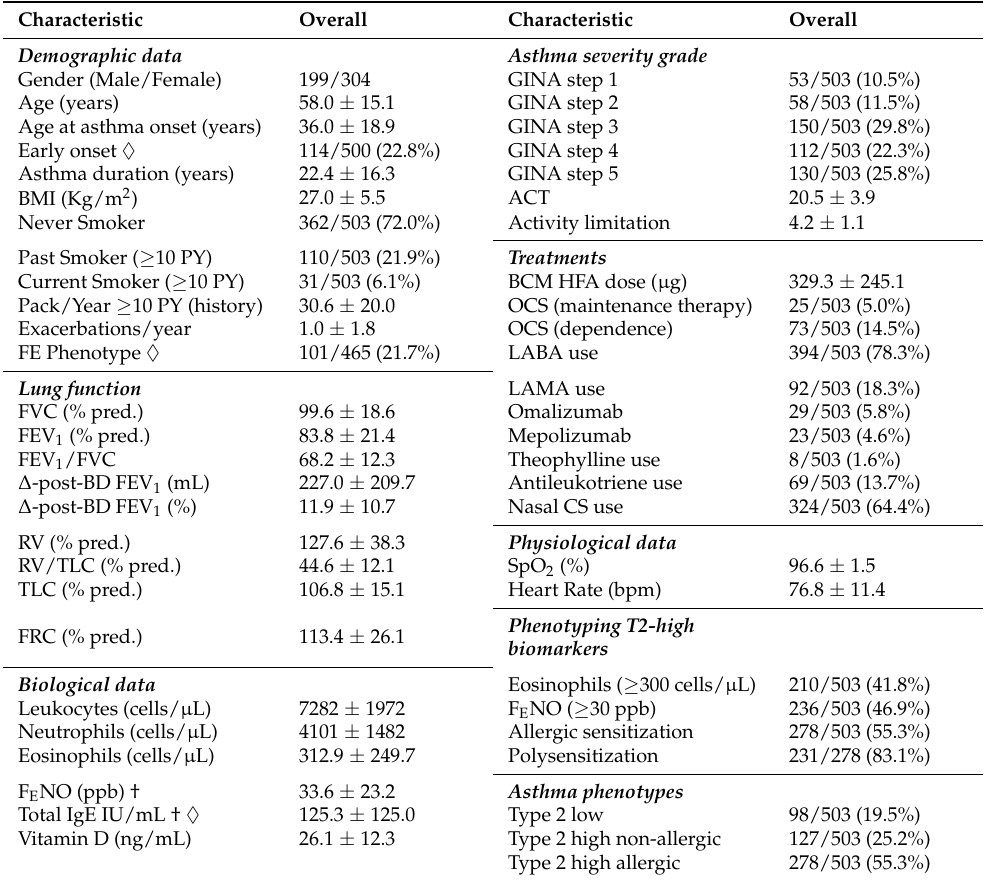
Table 1. Demographic and clinical characteristics of study participants ( n = 503). The results are expressed as mean with standard deviation or as the number of subjects with